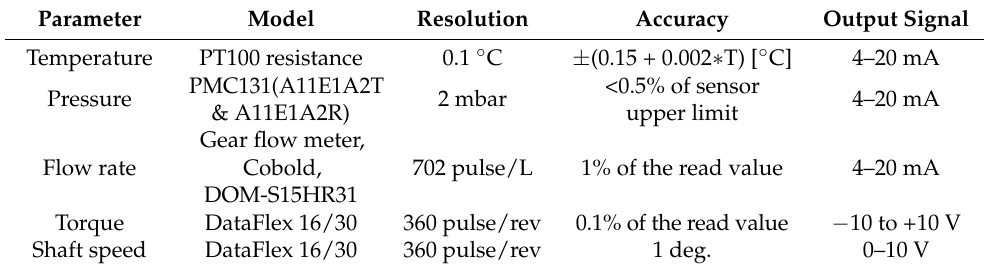
Table 2. Characteristics of the sensors of the ORC